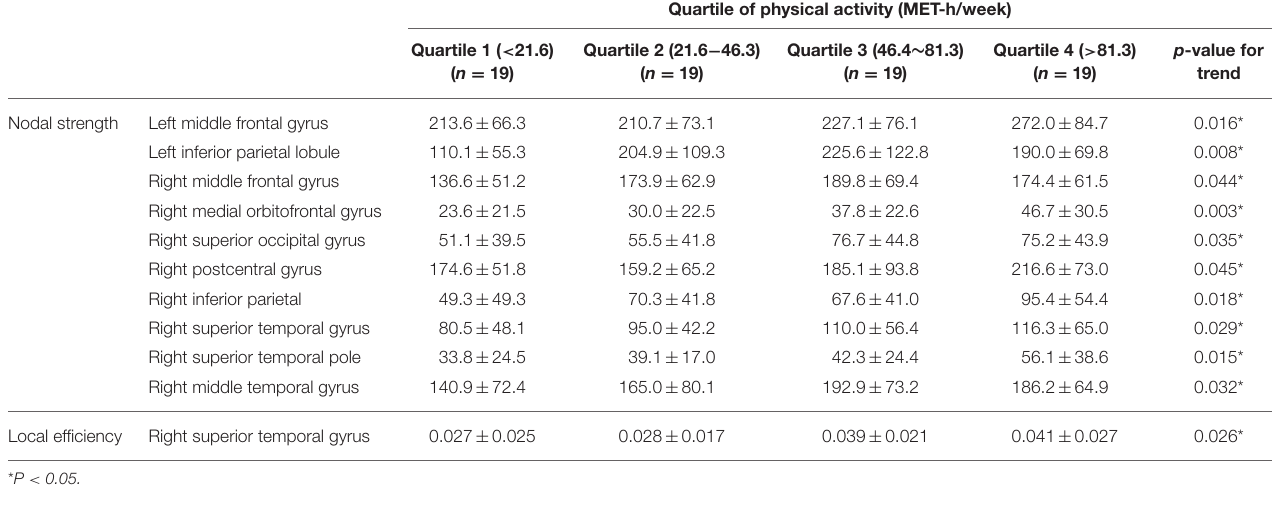
TABLE 4 | Brain regions showing linear trends in nodal strength and local efficiency.